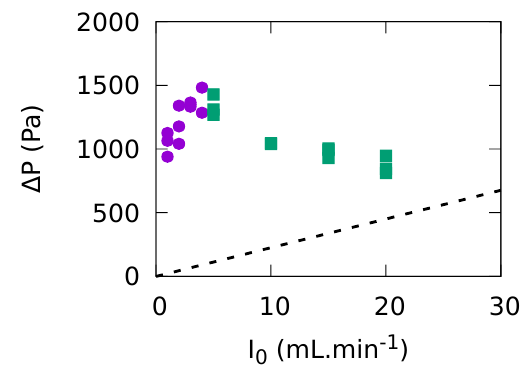
Figure 4. Pressure drop ∆ P measured after granular matter is introduced in the stream of water imposed by the syringe pump at flow rate I 0 . Rounded symbols correspond to hydraulic trans- port regimes exhibiting slugs formation and travelling, squared symbols correspond to hydraulic transport exhibiting moving bed characteristics. The dashed line indicates the Hagen-Poiseuille pressure drop prediction for pure